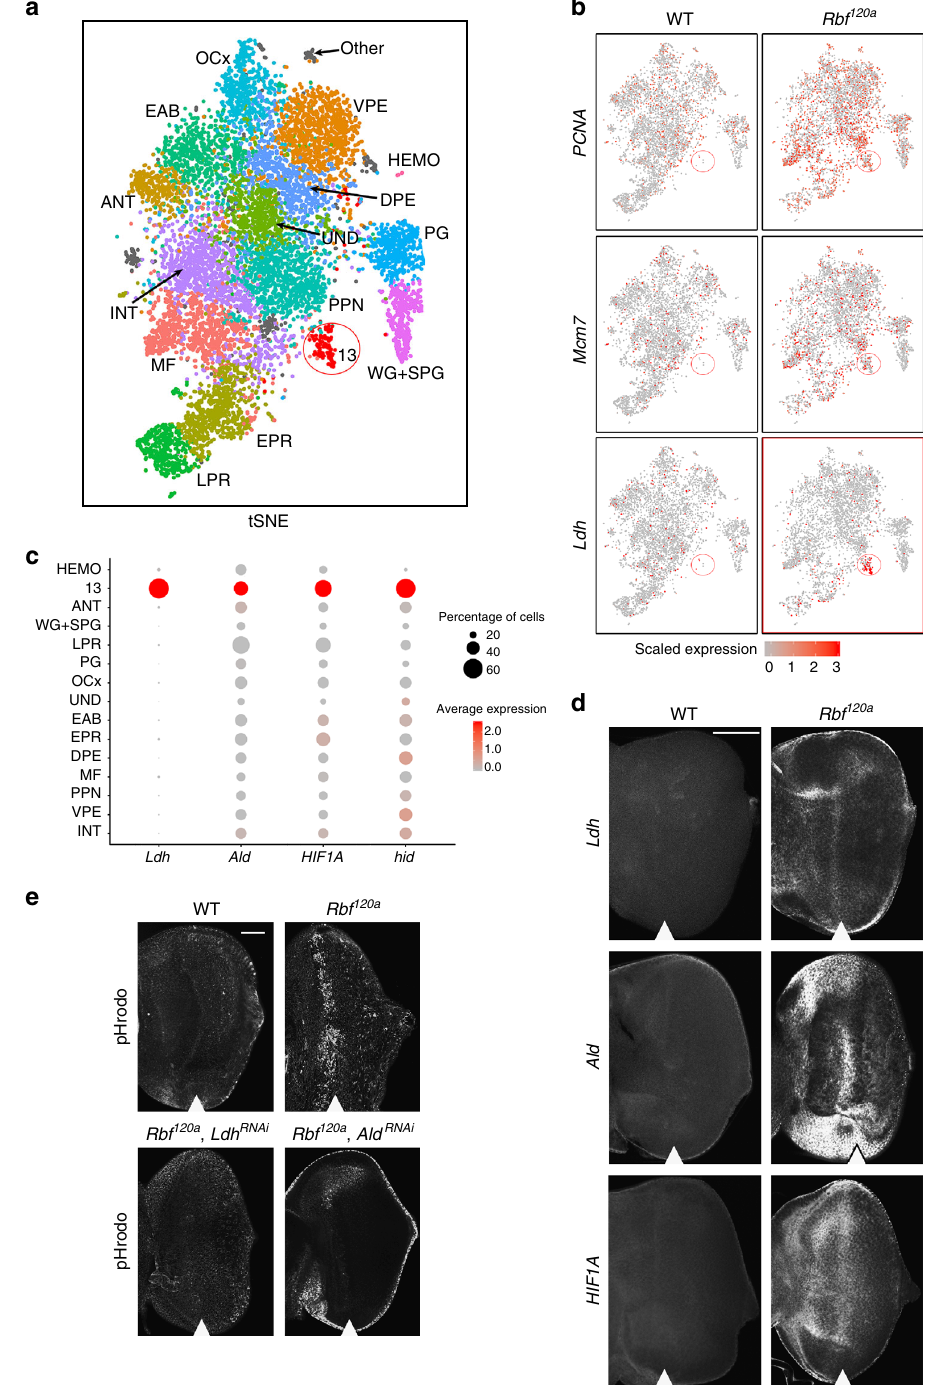
Fig. 5 Wild-type and Rbf 120a scRNA-seq identi fi es a mutant-speci fi c metabolic cluster. a Seurat analysis using a combined wild-type and Rbf mutant single- cell transcriptomes. Cluster 13, outlined in red, is almost exclusively comprised of Rbf 120a mutant cells. Clusters are color coded as in Fig. 1a. b Feature plots on tSNE showing the expression of PCNA , Mcm7 and Ldh in wild-type and Rbf mutant cells. Location of cluster 13 is outlined in red. c Dot plot showing expression of cluster 13 markers Ldh, Ald, HIF1a and hid throughout all clusters. d Expression of Ldh , Ald and HIF1A in the eye disc as revealed by FISH. The scale bar is 50 µ m. e Pattern of intracellular acidi fi cation as revealed by pHrodo. The scale bar is 50 µ m. The position of the MF is shown by white